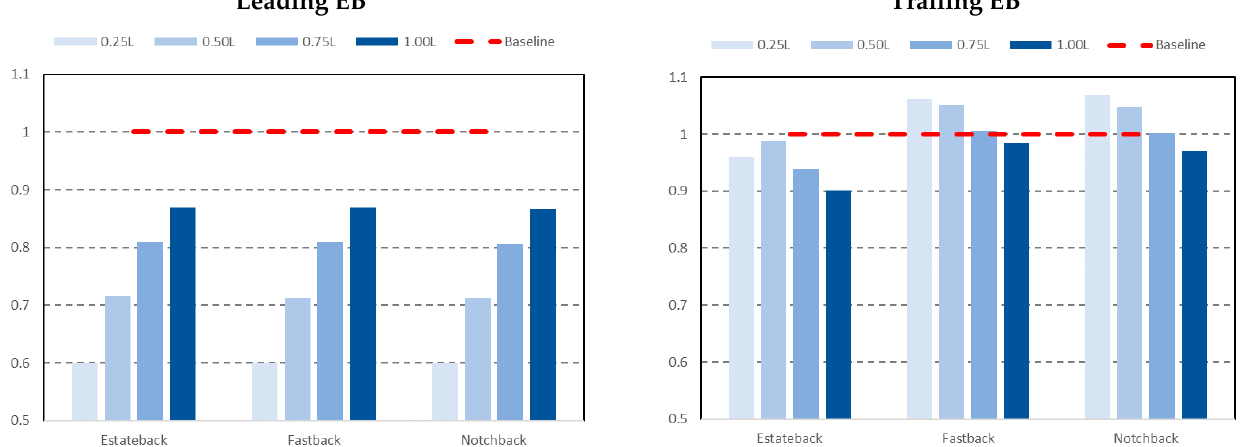
Figure 5. Drag ratios results of a leading EB ( left ) and a trailing EB ( right ) in different inter-vehicle spacing and configuration order normalised against the baseline results of an EB.